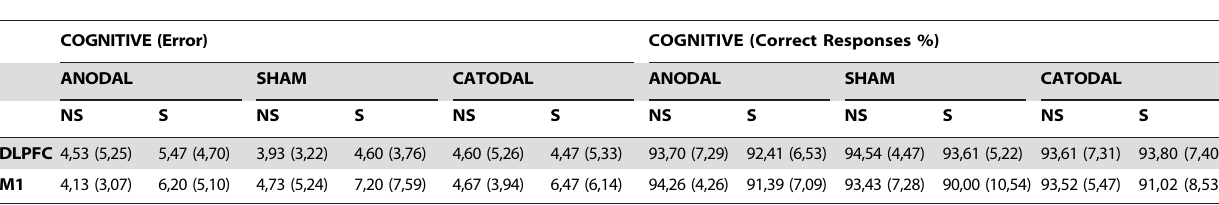
Table 1. Mean Number of errors and percentage of correct responses for the cognitive task.